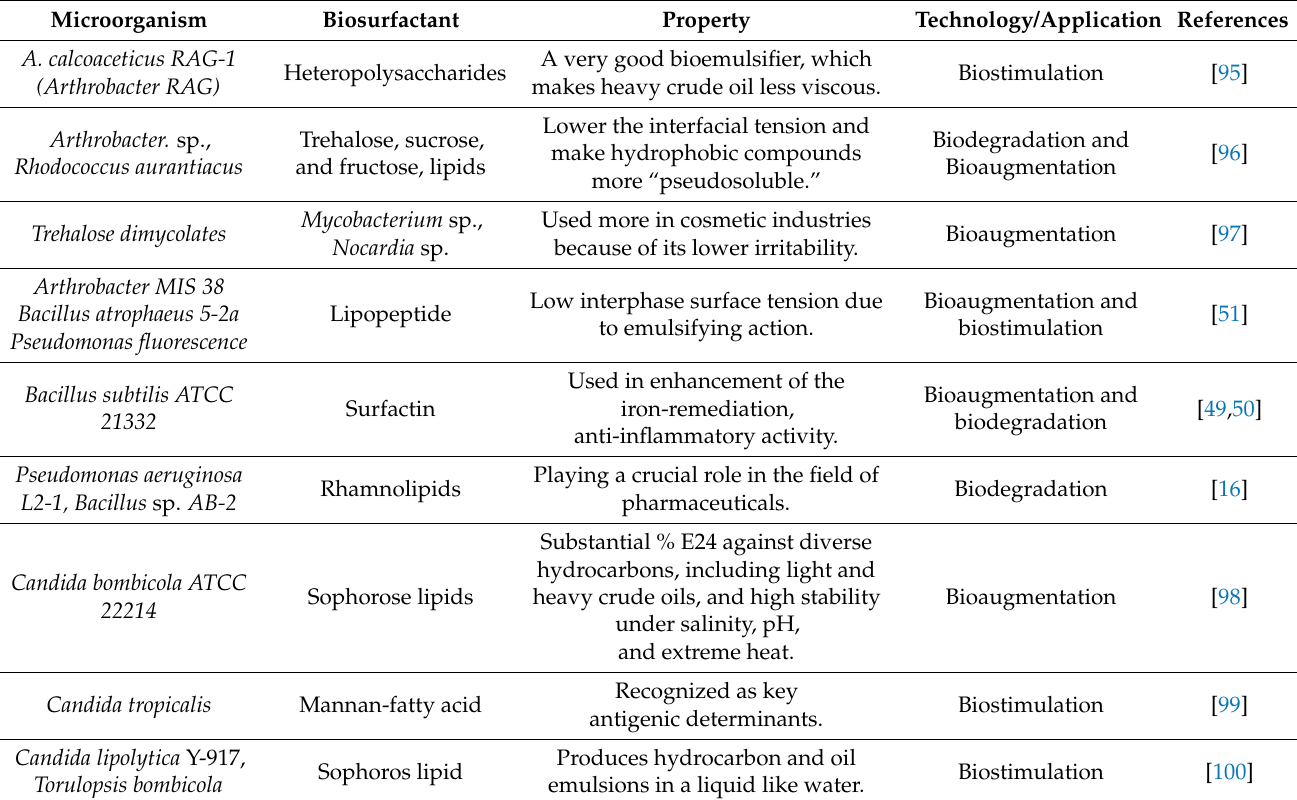
Various microorganisms contribute to the production of various biosurfactants. The detailed list is given in Table 2. Table 2. Various biosurfactants produced by